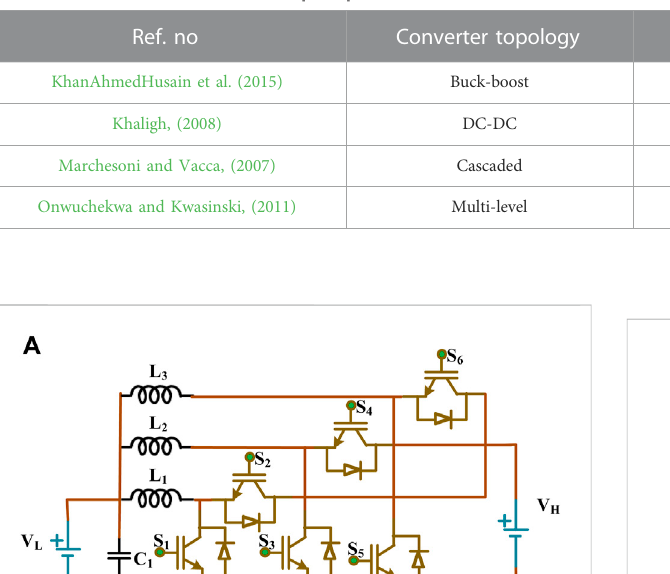
TABLE 4 Elements in non-isolated multiple-input converters.